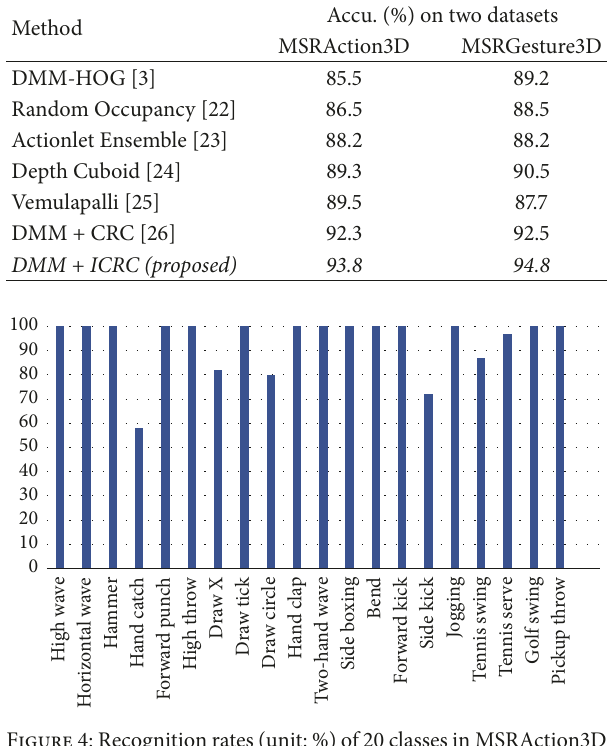
Figure 4: Recognition rates (unit: %) of 20 classes in MSRAction3D dataset (average results of three subsets).